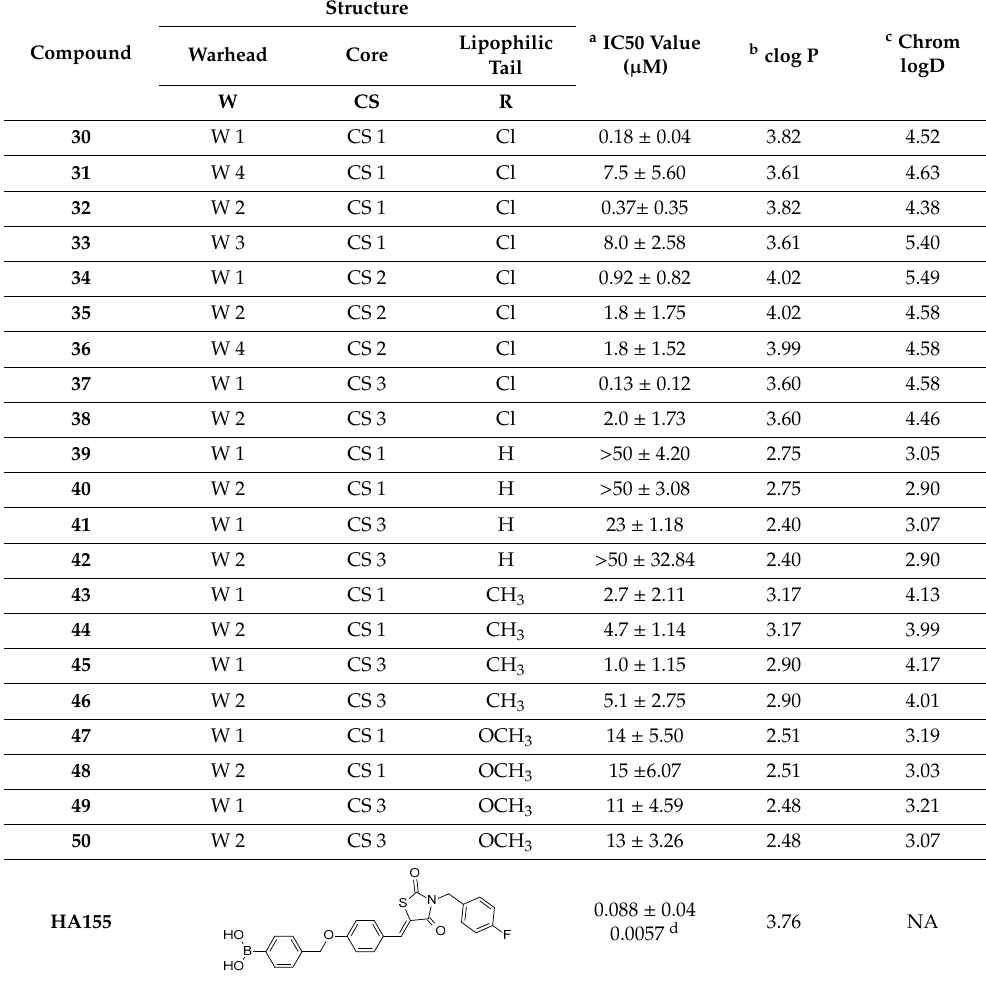
Table 1. Structures, inhibitory activities, calculated logP and determined Chrom logD values.